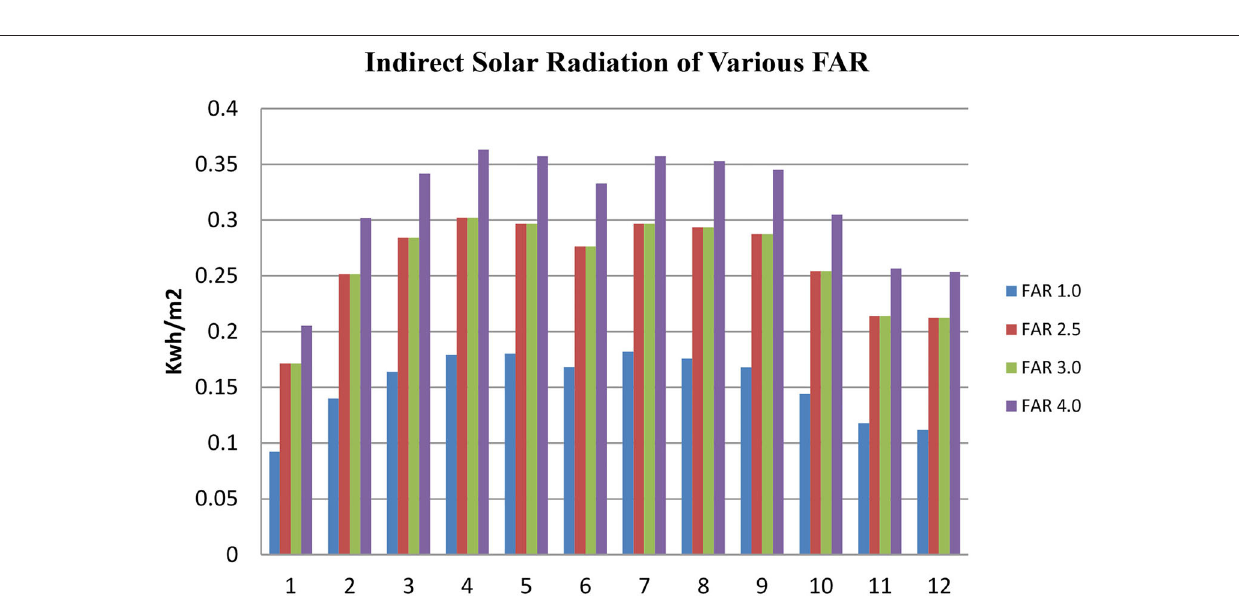
FIGURE 6 | Indirect solar radiation for various FAR (y-axis: indirect solar radiation in Kwh/m 2 ; x-axis: all months from January/1 to